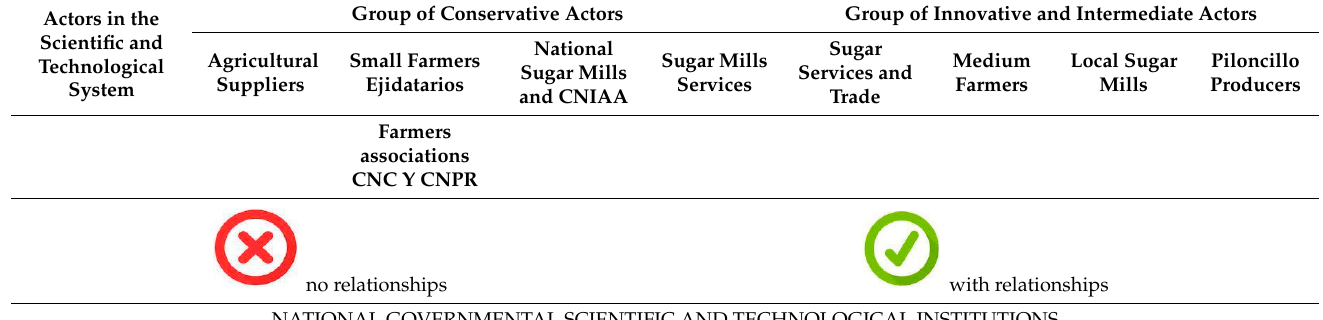
Table 3. Relations of R&D system with the conservative, intermediate and innovative network actors.